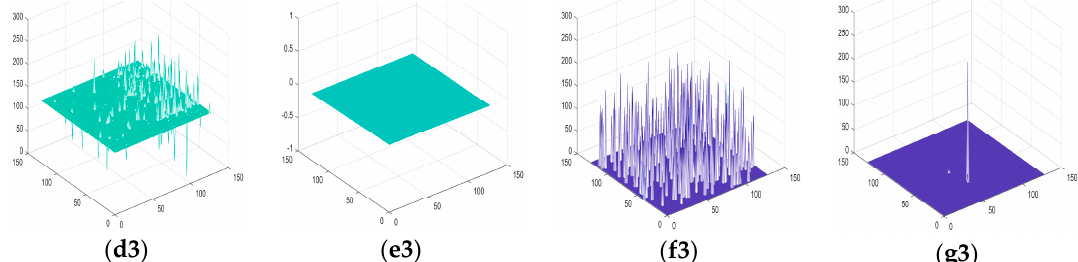
Figure 11. 3D gray maps of three representative scenes and corresponding results. ( a ) Original image; ( b ) MPCM; ( c ) IPI; ( d ) NIPPS; ( e ) SMSL; ( f ) RIPT; ( g ) NRAM.